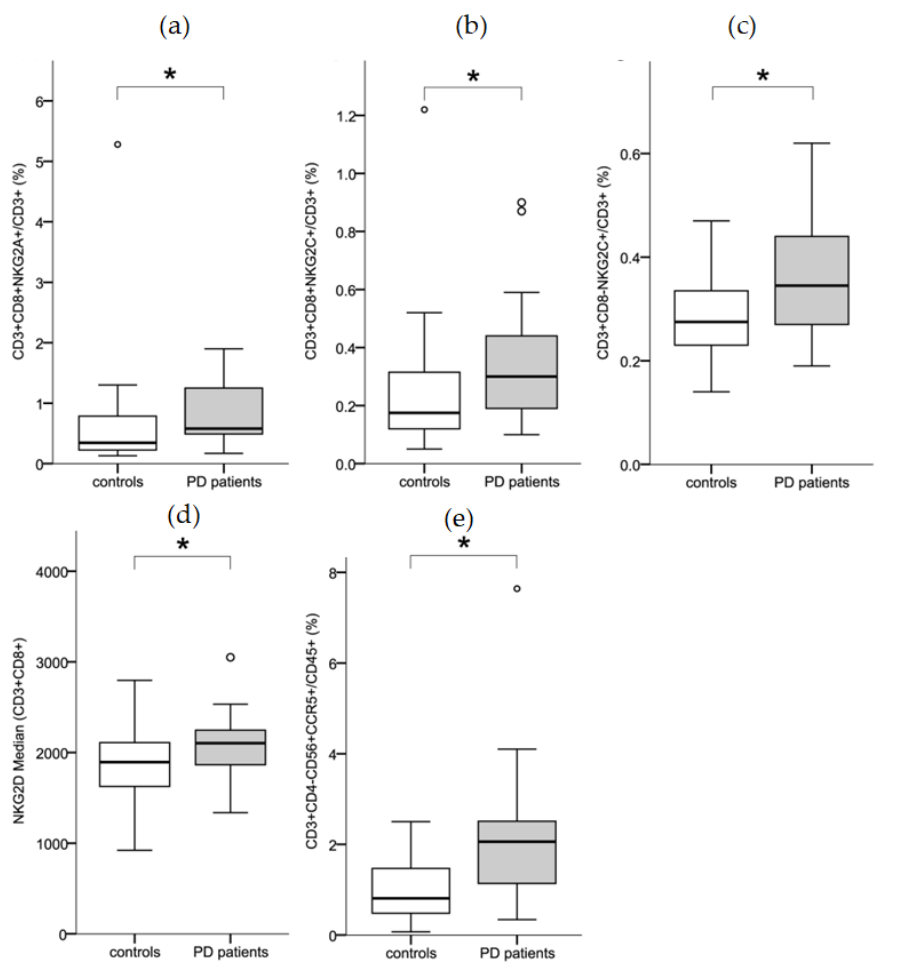
Figure 1. CD8+/ − T-cells. Frequencies of CD8+ T-cells expressing the receptors NKG2A ( a ) and NKG2C ( b ) and frequencies of CD8 − T-cells expressing the receptor NKG2C ( c ) relative to CD3+ cells. Median fluorescence intensities of receptor NKG2D on CD8+ T-cells ( d ). Frequencies of CD4-CD56+ NKT-cells expressing CCR5 ( e ). p -values were calculated using Mann – Whitney U Tests comparing PD patients to controls. Outliers are presented as circles. * p < 0.05. Of the three investigated chemokine receptors, the frequencies of T-cells and NKT- cells expressing CCR6 or CXCR3 were not significantly different between PD patients and controls. Only the proportion of CD4-CD56+ NKT-cells expressing CCR5 was found to be higher in PD patients (2.06% in PD patients and 0.81% in controls; p = 0.013; Figure 1e), although significance was reduced to a trend when %CD3+CD56 − T-cells were used as the reference population instead of %CD45+ cells. Median frequencies of CCR5- expressing CD4+ T-cells did not reveal a difference between PD patients and controls, in neither the activated (CD56+) nor not activated states (CD56 − ) (Figure S9). Regarding NK- cells, median frequencies of CCR5-expressing mature NK-cells did not differ significantly between PD patients and controls (Table 1).